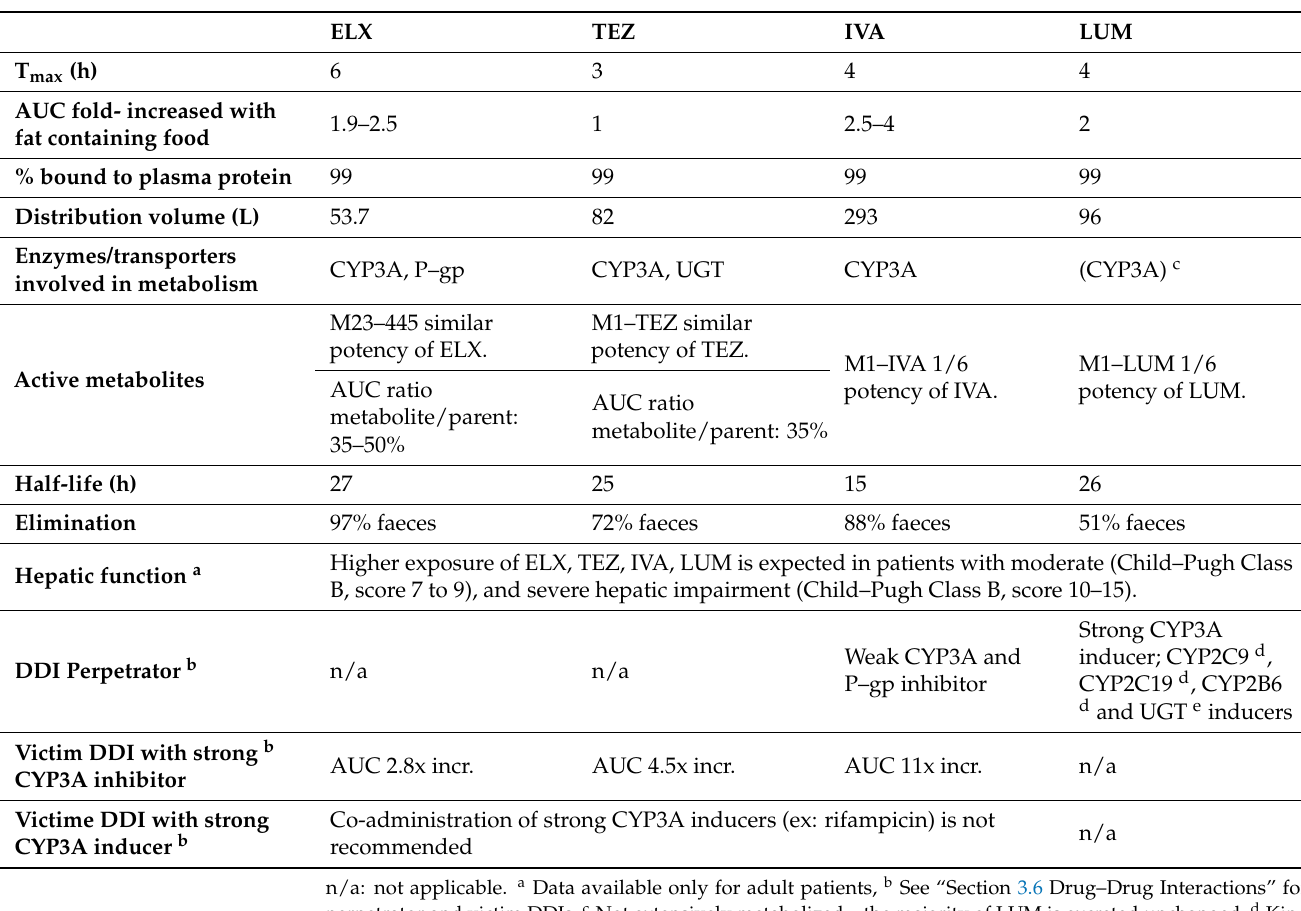
Table 1. Relevant pharmacokinetics parameters for the 4 currently approved CFTR modulators